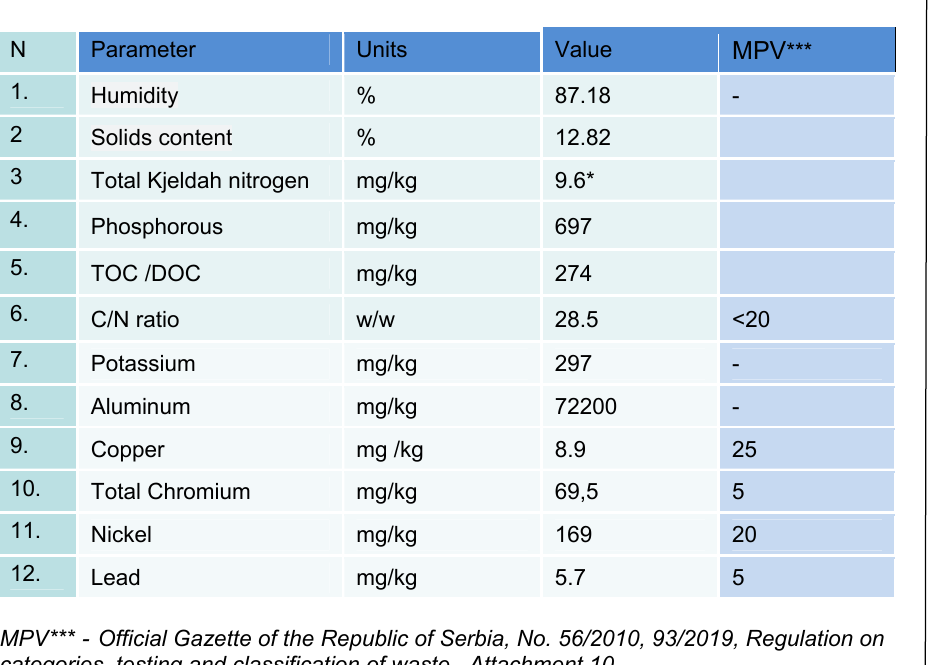
Table 3 – Results of the physico-chemical analysis of